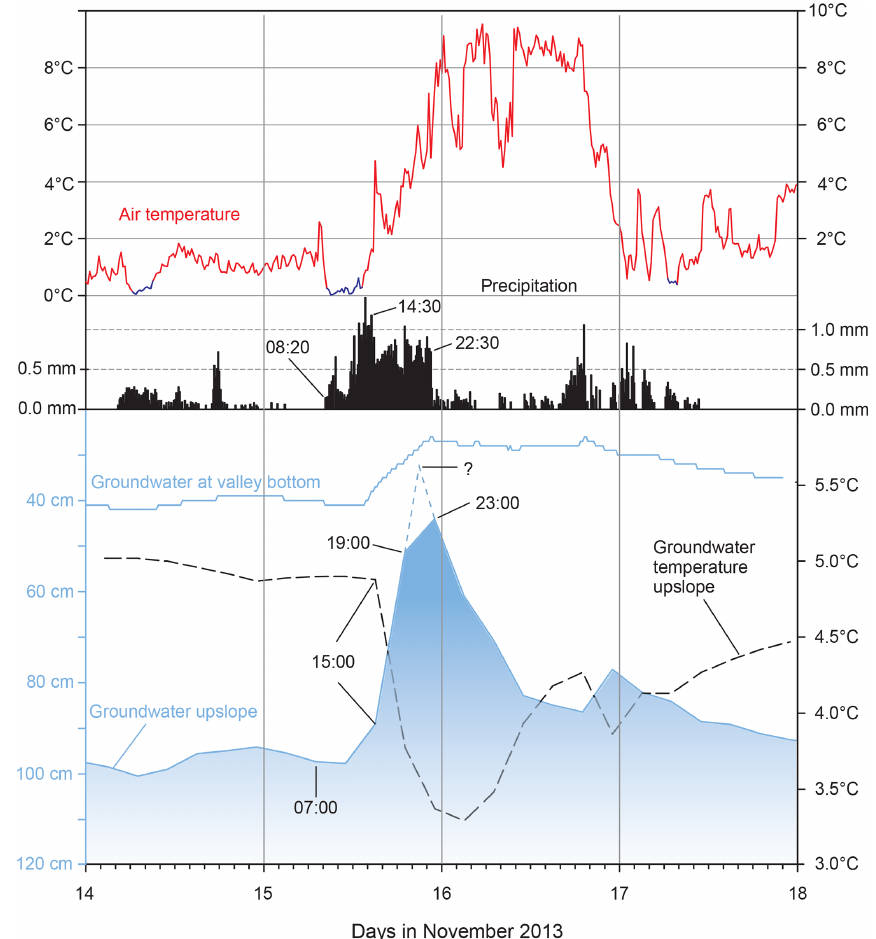
Figure 8. Air temperatures, precipitation and groundwater between 14 and 18 November 2013. The upper diagram shows air temperature (red curve) and precipitation in millimeters (mm) every 10min. The lower diagram shows the groundwater level and groundwater temperature. Blue segments of the air temperature curve show periods when the temperature is close to 0 ◦ C. Groundwater probably reached its highest level between 19:00 and 23:00, shown as a dotted line and a question